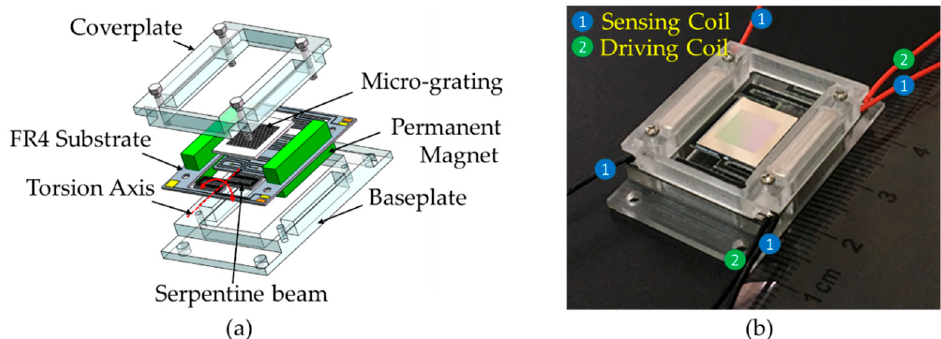
Figure 1. ( a ) Schematic drawing of the assembled flame-retardant 4 (FR4)-based electromagnetic scanning micrograting; and, ( b ) a photograph of the prototype of the FR4 scanning micrograting integrated with a driving coil and a pair of sensors. Table 1. Parameters of the FR4-based electromagnetic scanning micrograting.